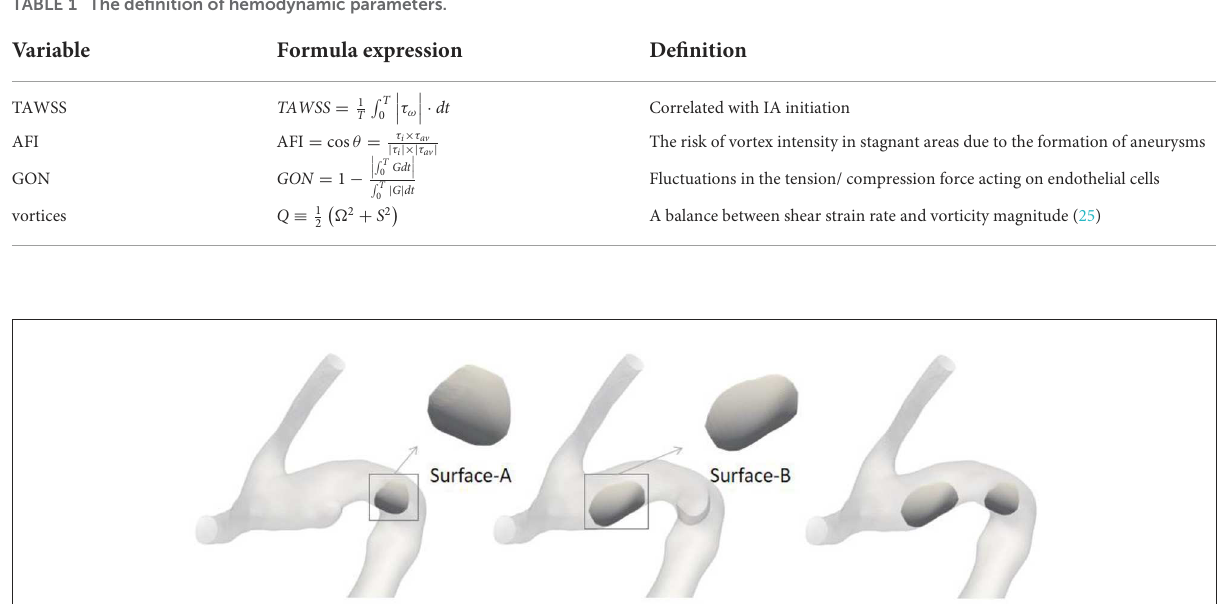
TABLE 1 The definition of hemodynamic parameters.